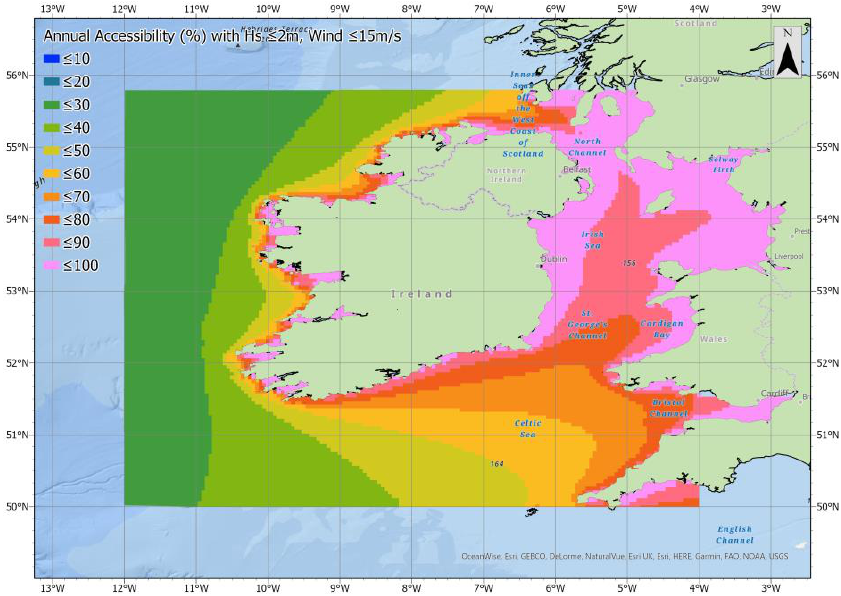
Figure 12. Annual accessibility (%) based on HLV operating limits of 2 m H s and 15 m/s wind speed.